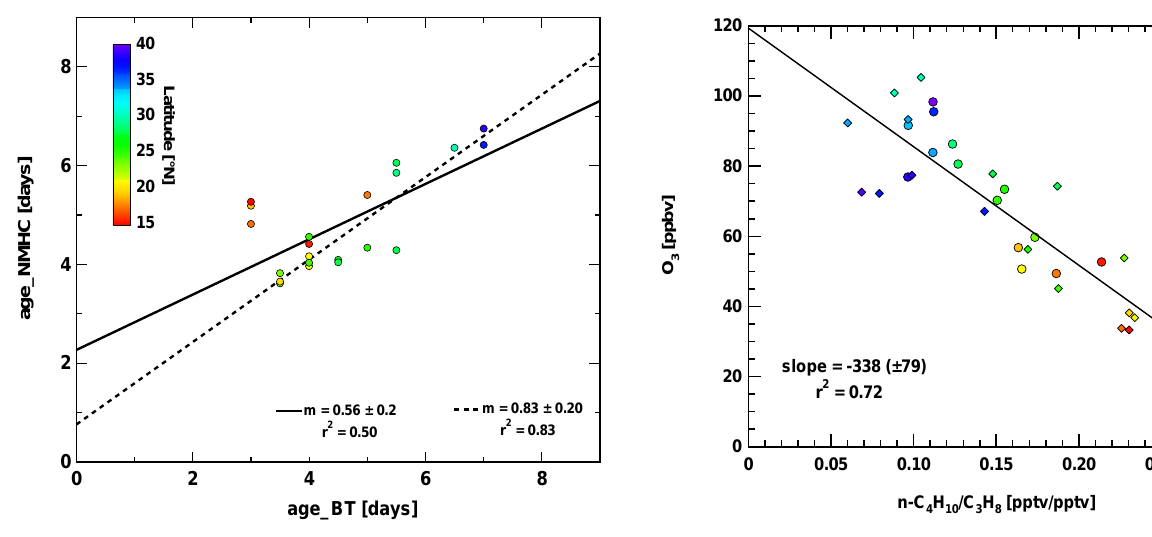
Fig. 9. Comparison of ages determined from NMHC in CARIBIC samples (age NMHC, which is the average age determined from the ratios of propane and n-butane to ethane) and the age estimated from backwards trajectories (age BT) for those samples where back- wards trajectories showed low level contact within the preceding 8 days. The solid black line is the linear fit to all data; the dashed black line is the fit to the data if the 3 outliers are excluded (see text). Points are color-coded by sampling location latitude.